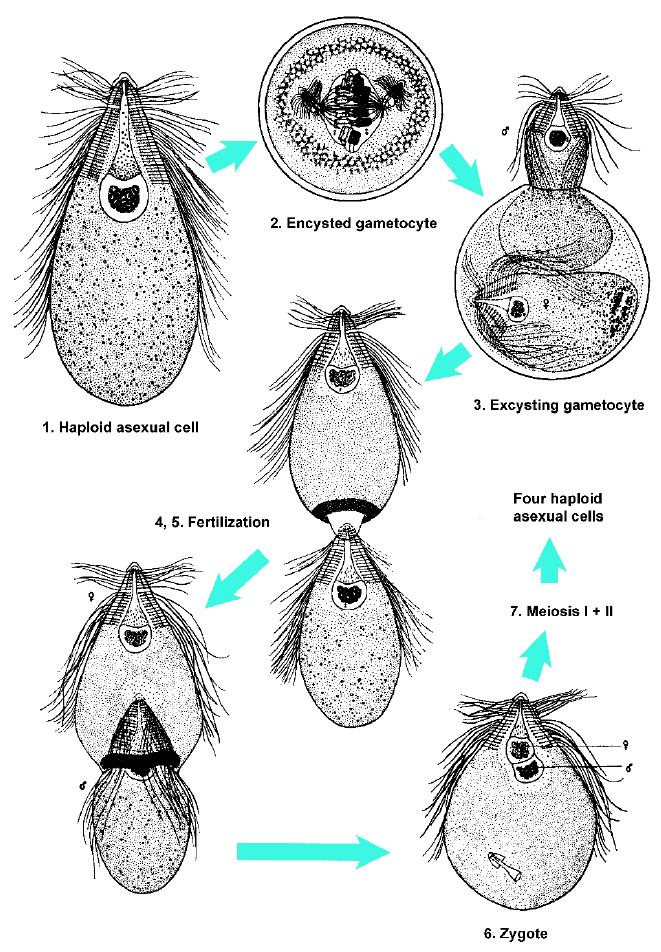
Figure 5. Sexual/encystment (SE) cycle in Trichonympha . After Figure A in Cleveland [167], with permission from John Wiley and Sons. permission from John Wiley and